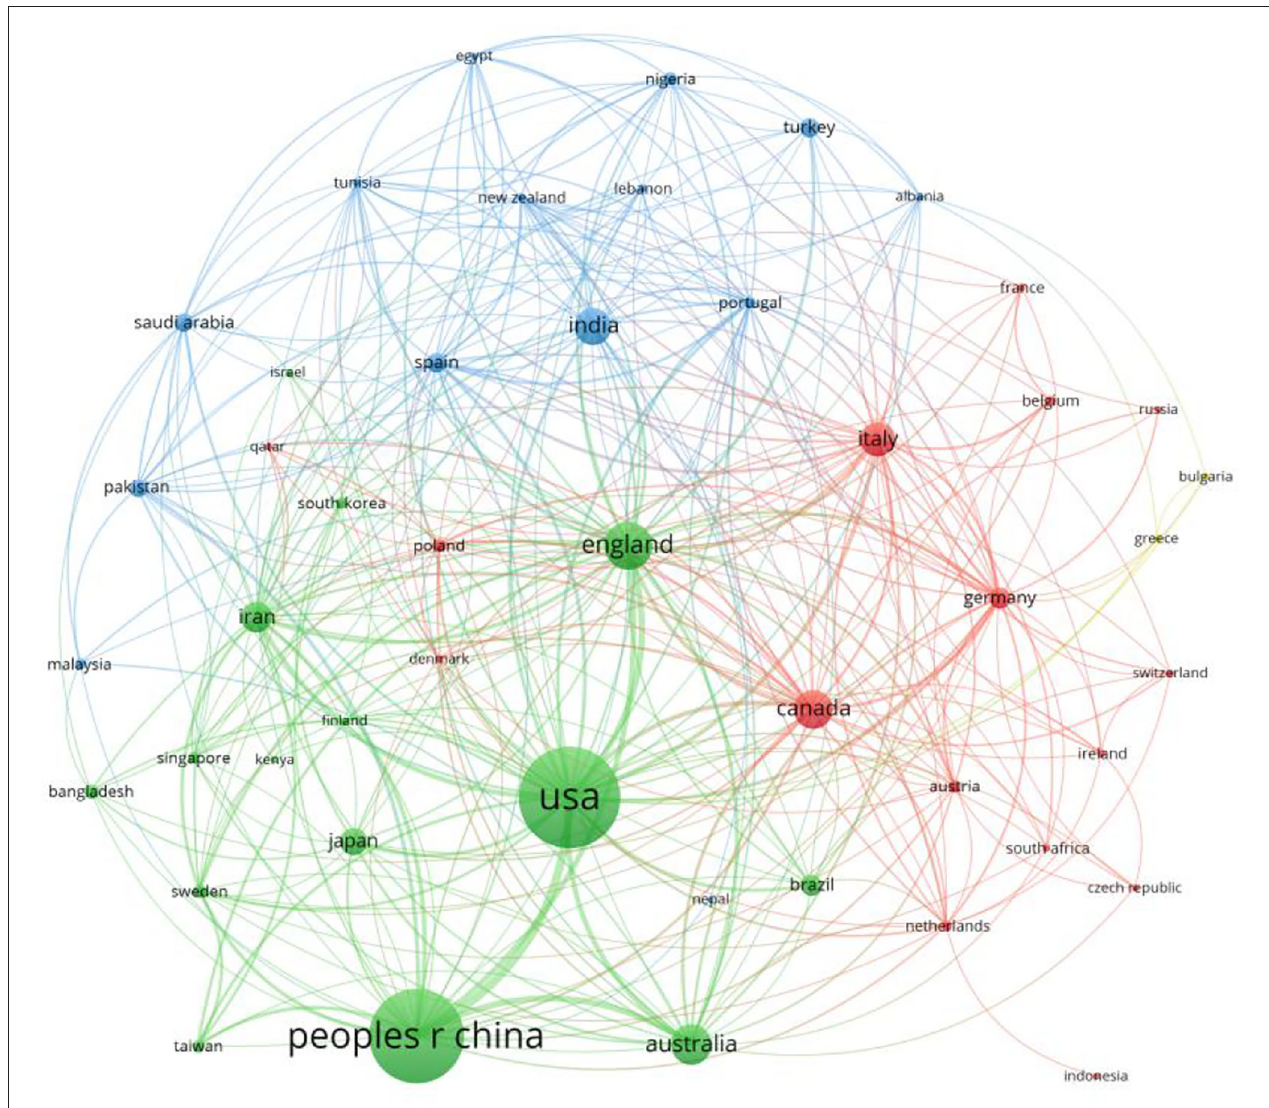
FIGURE 2 | Country or region co-occurrence.